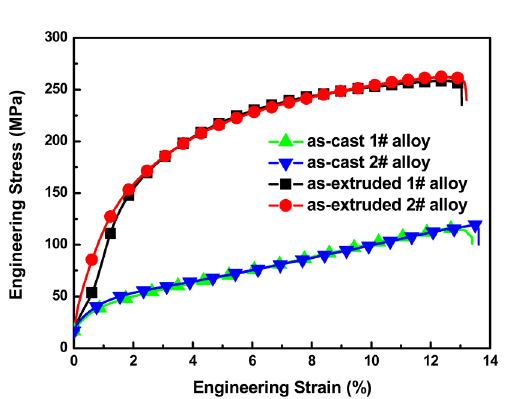
Figure 5. The engineering stress-strain curves of as-cast and as- extruded Mg-xZn-0.3Mn (1#: Mg-1.5Zn-0.3Mn, 2#: